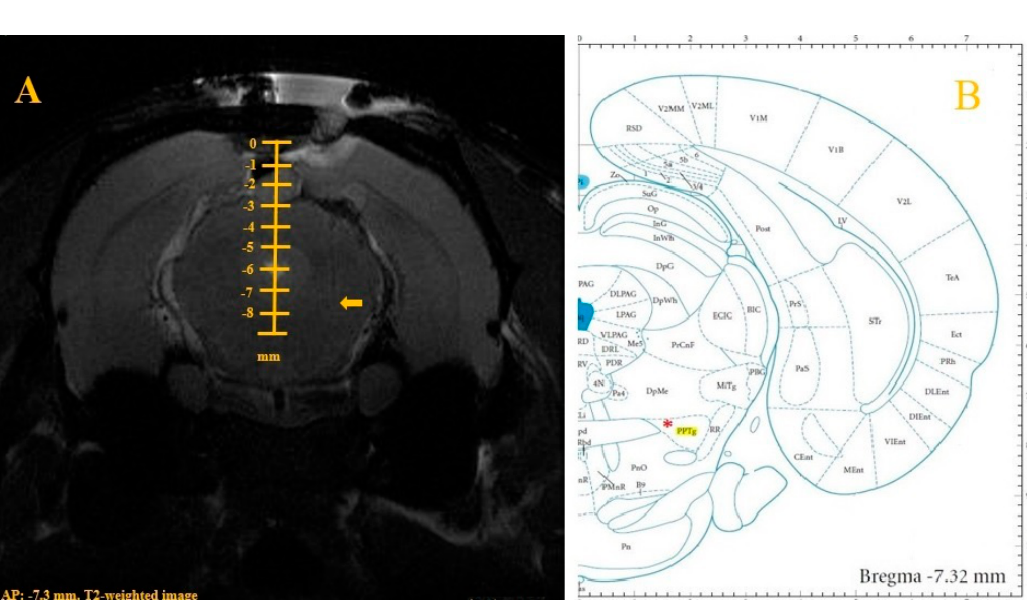
Figure 4. Example of a T2-weighted coronal image for measuring the target point of the tip of a deep brain stimulation (DBS) electrode in a rat with a traumatic brain injury (TBI). ( A )—The tip of the DBS electrode was precisely located at the central point of the pedunculopontine tegmental nucleus (PPTg) (AP, − 7.3 mm; L, + 2.0 mm; and DV, − 7.5 mm). The arrow indicates the electrode tip point. ( B )—Schematic representation of the ventral PPTg in an atlas. The red asterisk indicates the ventral point of the PPTg (AP − 7.3 mm, L + 2.0 mm, DV − 7.5 mm).